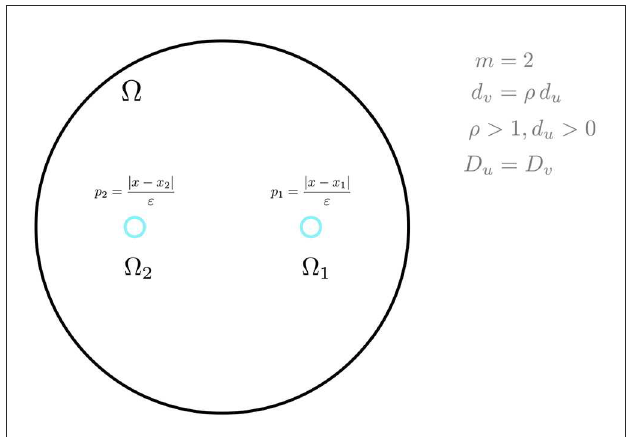
FIGURE2 A schematic plot of a ring pattern in the unit disk with two cells. The bifurcation parameter for symmetry-breaking is ρ , while the D v diffusivities satisfy D u =